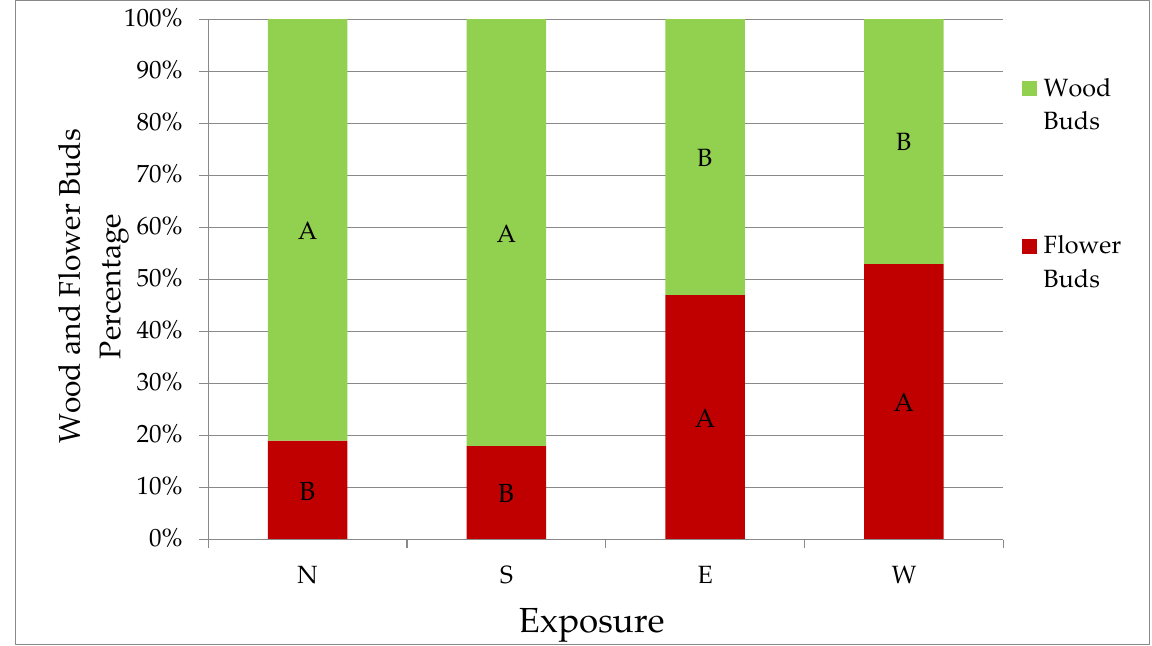
Figure 1. Wood and flower buds percentage per shoot for a given exposure (North, South, East, West). The 100% represents the total buds number per shoot. The letters denote significant differences among exposures ( p = 0.01; SNK test).